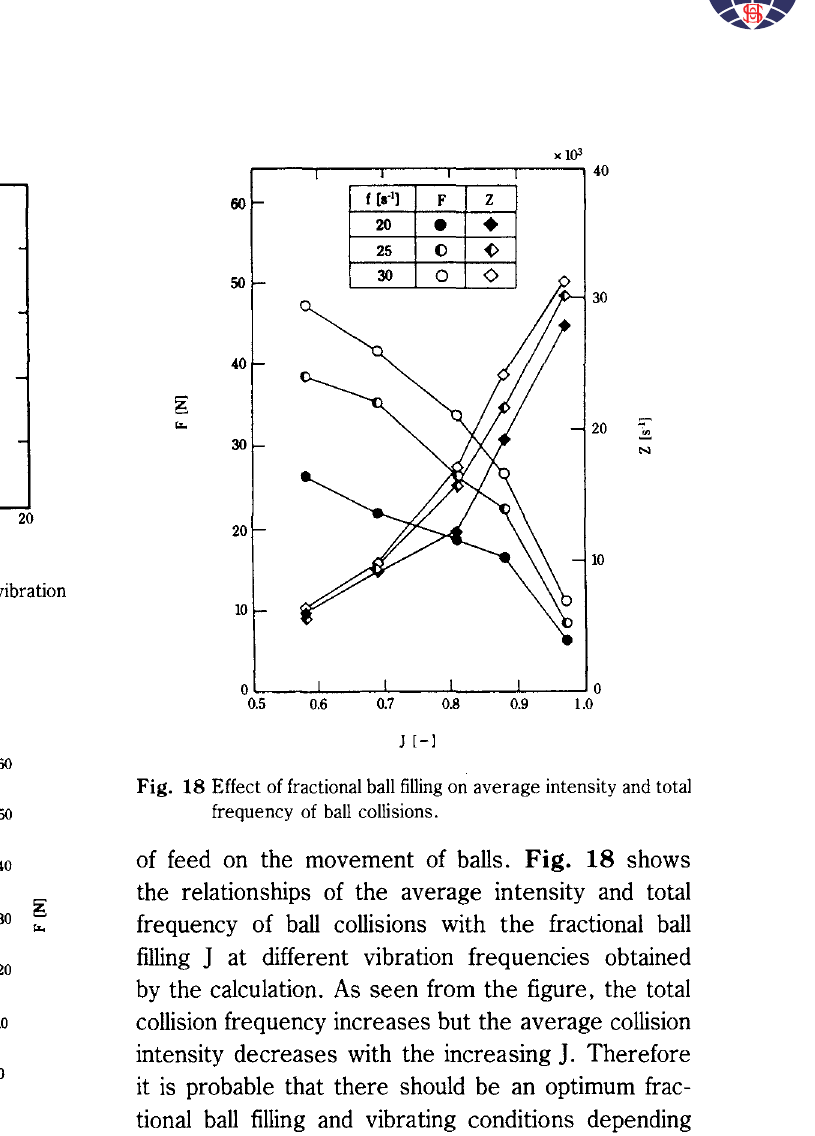
Fig. 15 Change of average ball collision intensity with vibration intensity.